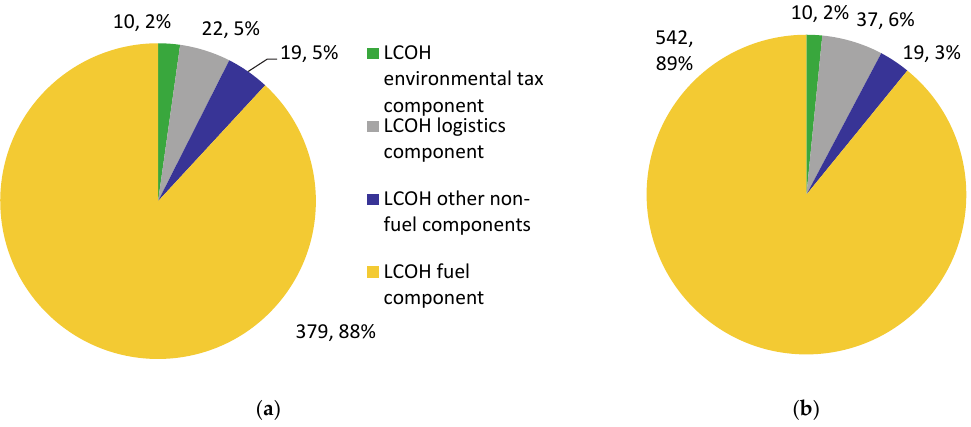
Figure 7. LCOH structure from KZOT BRS 1000 Comfort BM (1 MW) from coal: ( a ) January 2022; ( b ) July 2022.